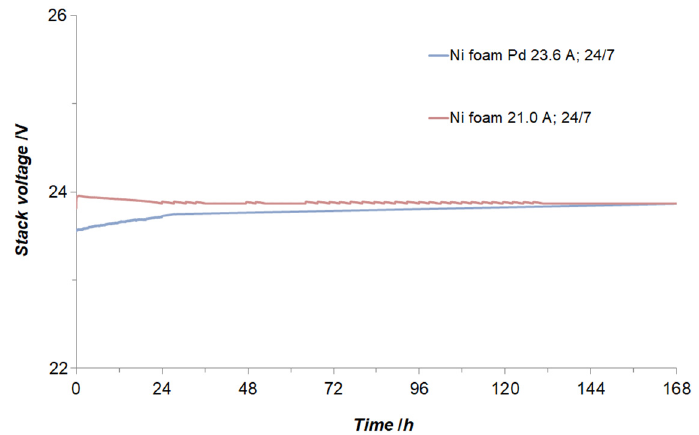
Figure 10. Electrolyser stack’s voltage in function of electrolysis time during long-term (7 days) AWE tests. The process was carried out at 45 °C in 8 M KOH solution for the set current intensities of 21.0 and 23.6 A respectively, for cathodes made of unmodified and Pd-modified nickel foam (solution recirculation rate was set at 50 cm 3 min − 1 ). Table 4. Chromatographic analysis of hydrogen and oxygen gas samples generated by means of 500 W AWE